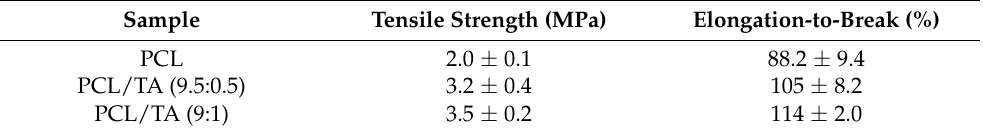
Figure 4. Stress-strain curves of electrospun nanofiber scaffolds spun from PCL and from solutions with different PCL/TA weight ratios (9.5:0.5 and 9:1). Table 1. Mechanical properties of electrospun nanofiber scaffolds spun from PCL and from solutions with different PCL/TA weight ratios (9.5:0.5 and 9:1); the tensile strength and elongation-to-break of electrospun PCL/TA (9.5:0.5, 9:1) nanofiber scaffolds are significantly different from those of the PCL nanofiber scaffolds, p < 0.05.